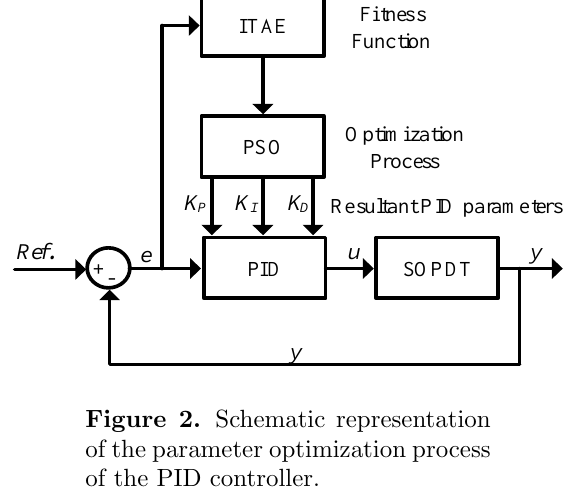
Figure 2. Schematic representation of the parameter optimization process of the PID